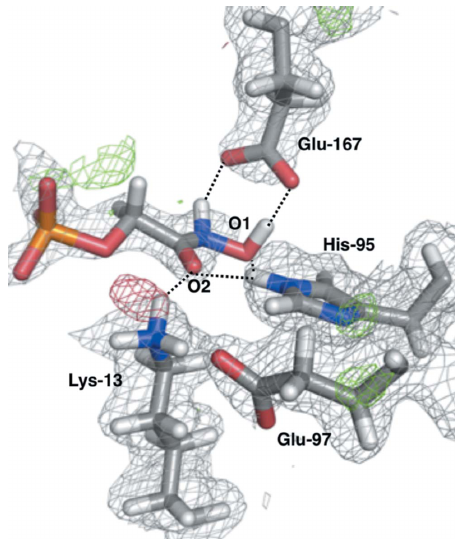
Figure 6 Quantum-refined joint X-ray/neutron structure of PGH–TIM with the 2 mF (cid:5) DF c nuclear scattering-length density map contoured at 1.0 (cid:2) and the mF o (cid:5) DF c nuclear scattering-length difference density maps contoured at 3.0 (cid:2) (green) and (cid:5) 3.0 (cid:2) (red).